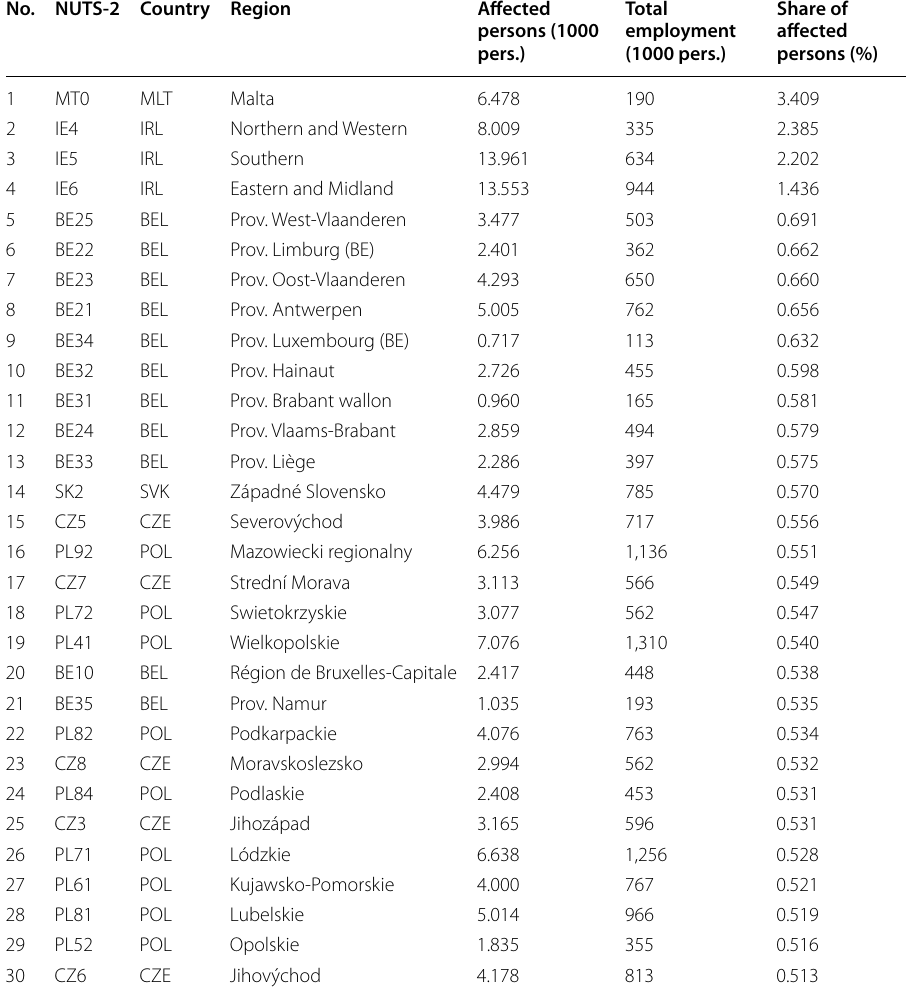
Ordered by share of affected persons. Source: World Input–Output Database, Eurostat (regional employment data) and own